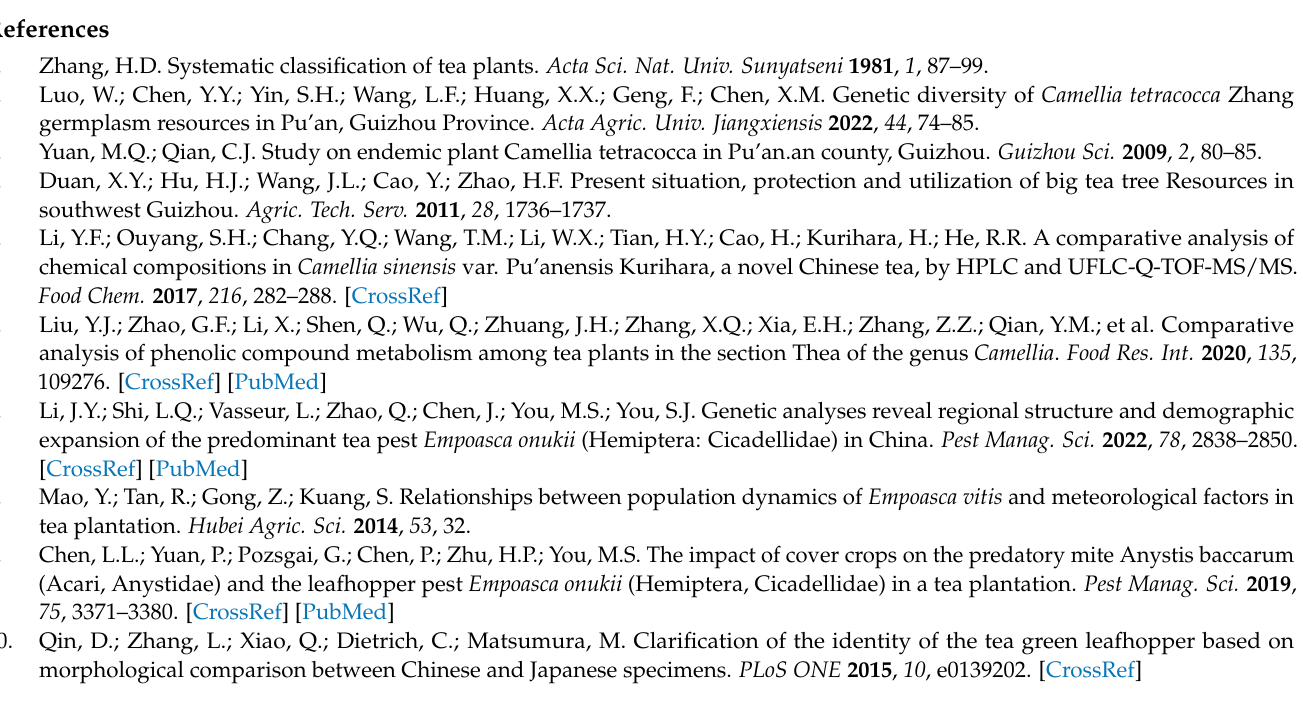
group E, red circles represent group N; Figure S6: PCA score plot (PC1, PC2, PC3) in GC-MS. Blue squares represent group E, red circles represent group N. Table S1: All differential metabolites